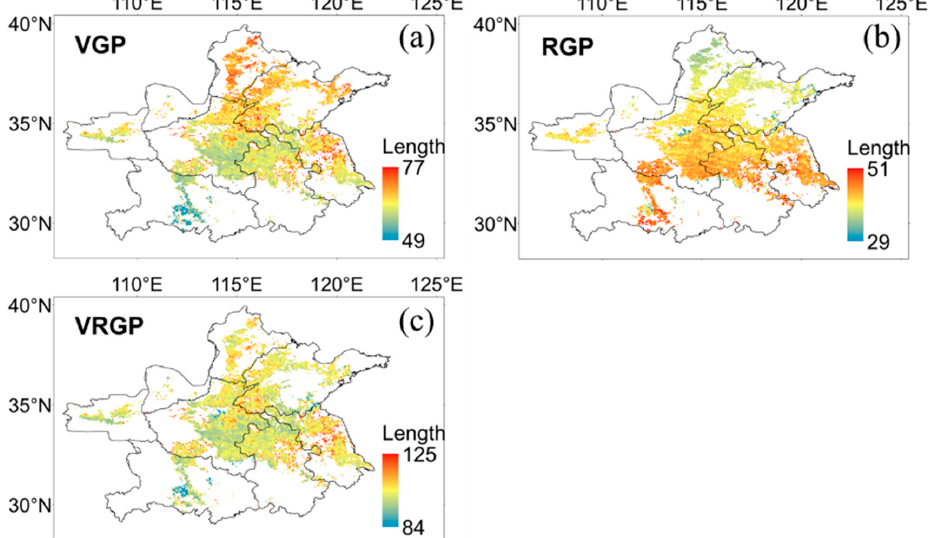
Figure 7. Spatial distribution of multiyear averages of different growth periods extracted from VIP data. VGP represents the vegetative growth period, RGP represents the reproductive growth period, and VRGP represents the vegetative and reproductive growth periods combined. ( a ) represents spatial patterns of multiyear averages for VGP, ( b ) represents spatial patterns of multiyear averages for RGP, and ( c ) represents spatial patterns of multiyear averages for VRGP, respectively.